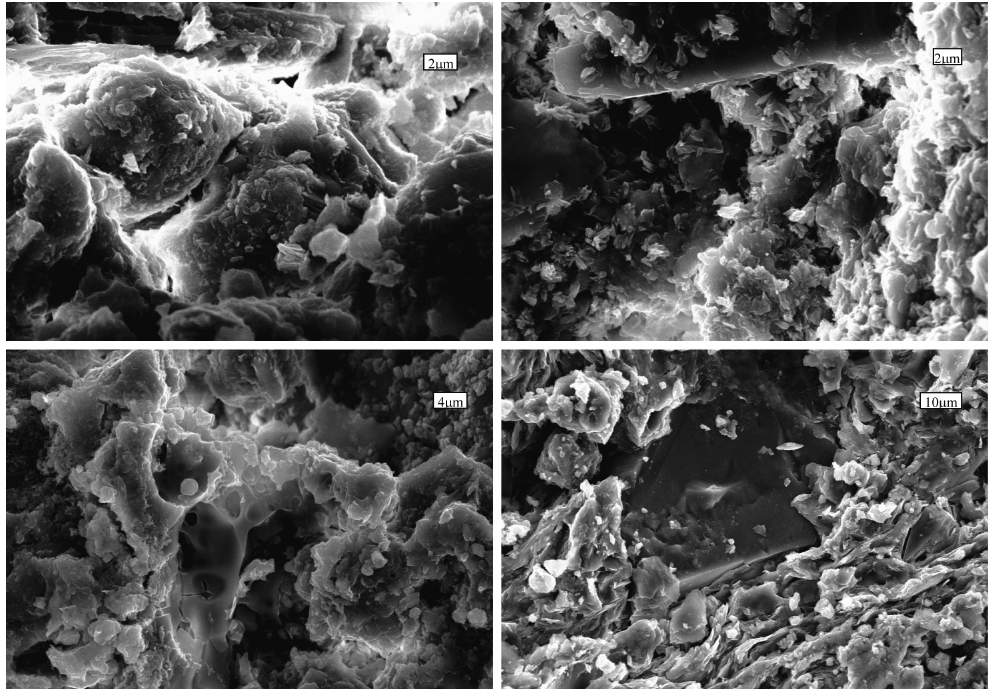
Figure 4 SEM photographs of 15MD+30FA (56 days cured).